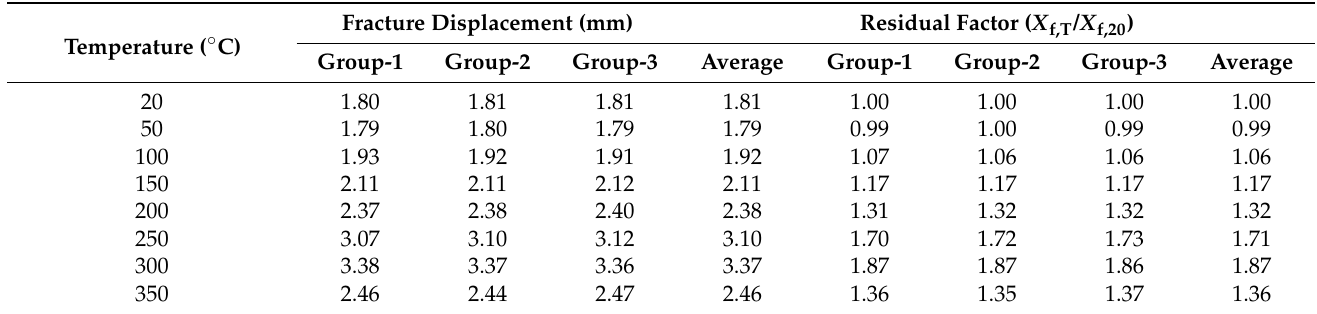
Table 4. Fracture displacements and residual factors of the FRP composites at elevated